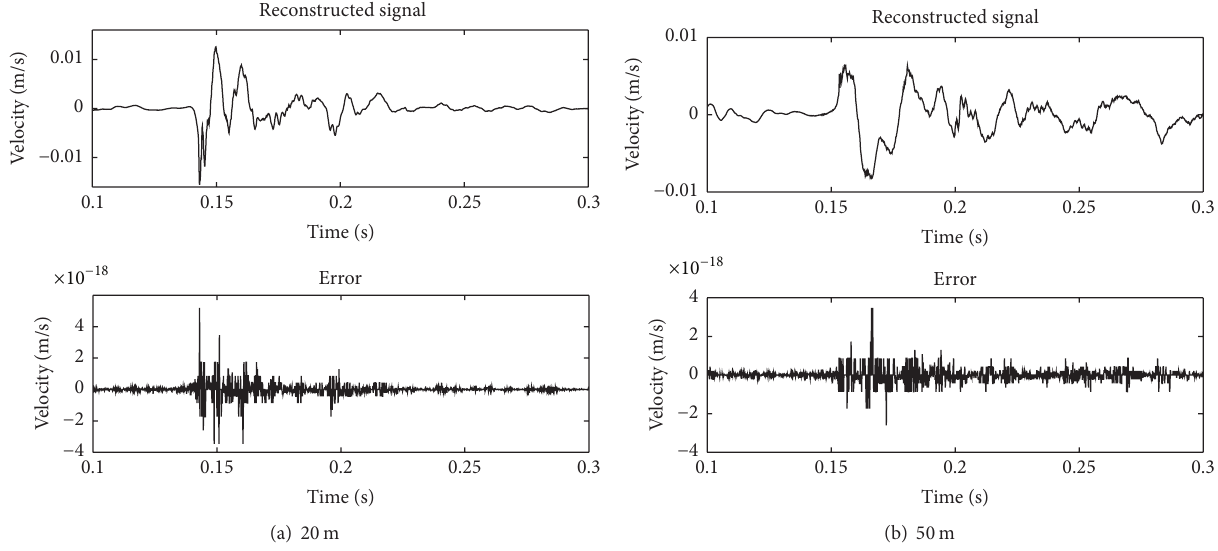
Figure 12: Time history curve and reconstructing signals and error graph of blasting vibration velocity at different measuring points.